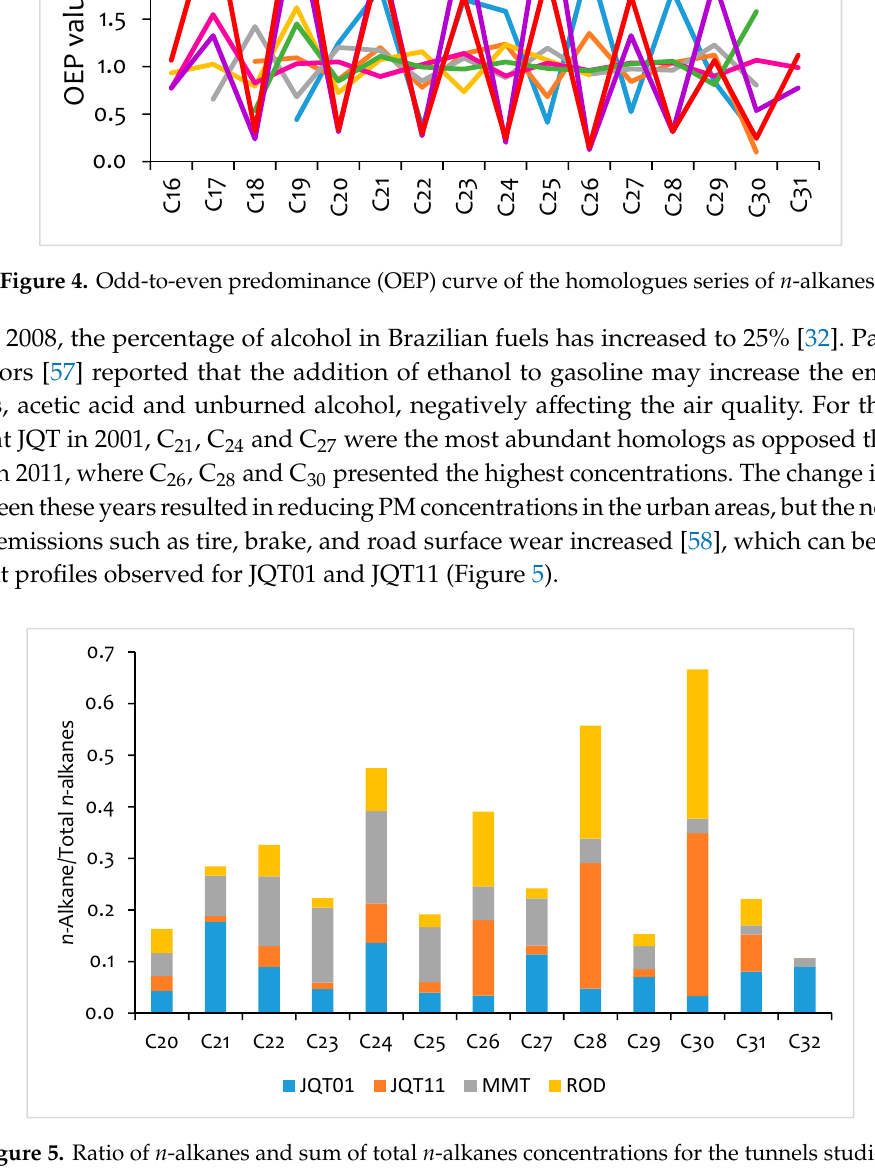
Figure 5. Ratio of n -alkanes and sum of total n -alkanes concentrations for the tunnels studied.